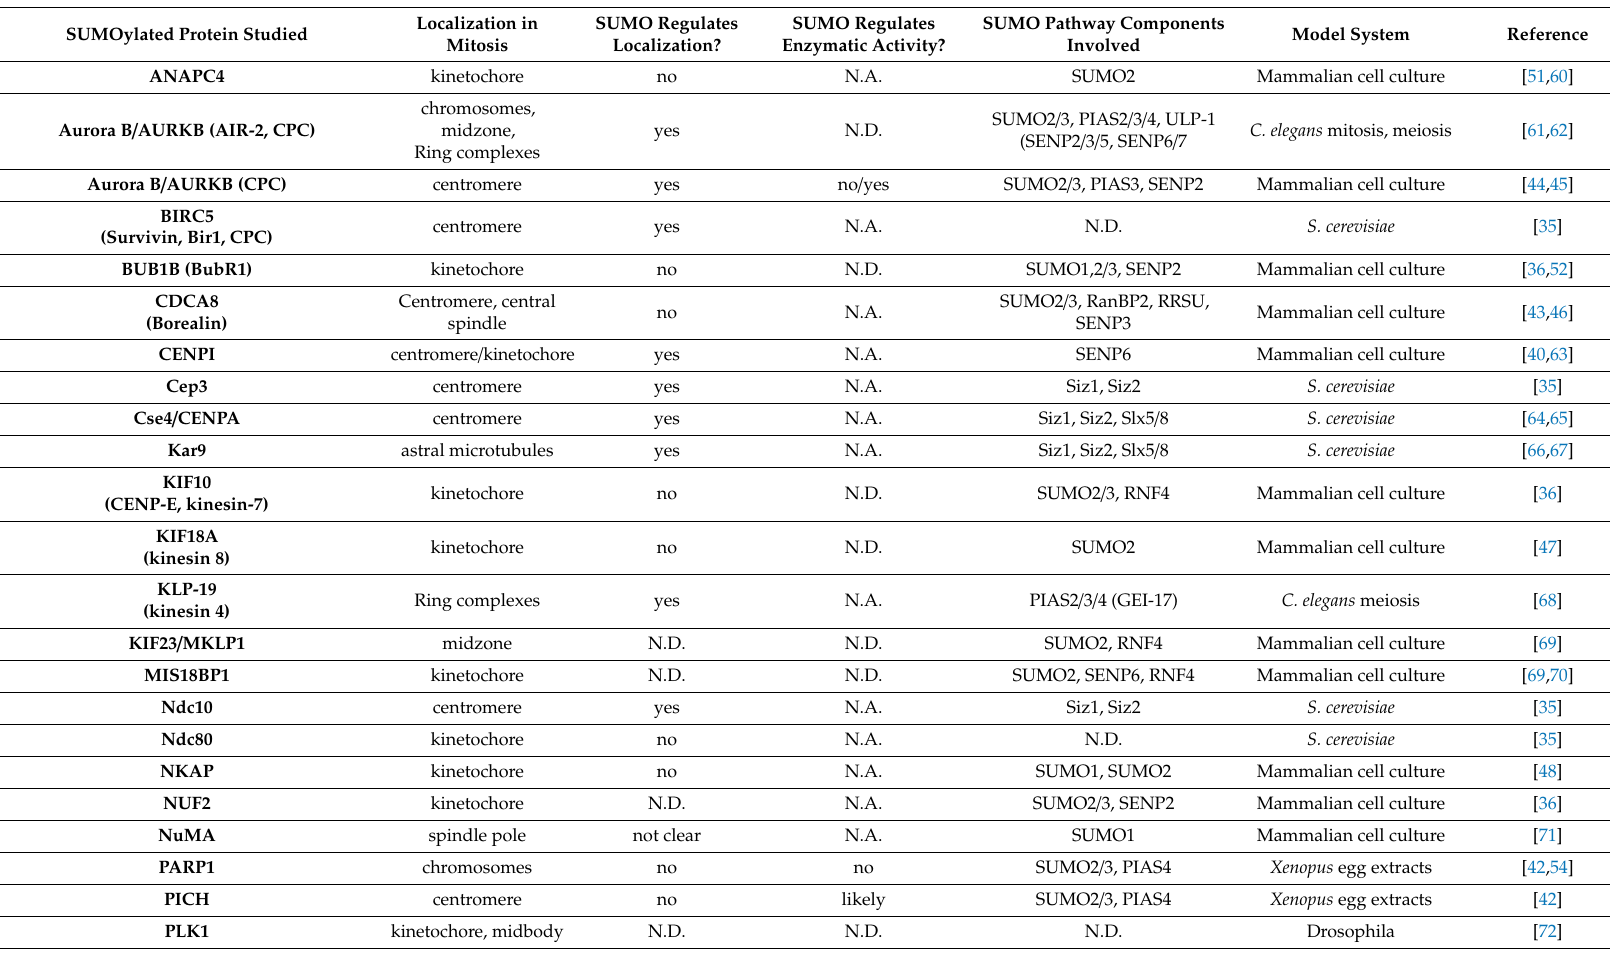
Table 1. List of the SUMOylated spindle proteins for which the function of SUMOylation has been studied in the listed publications and model systems. SUMOylated Protein Studied